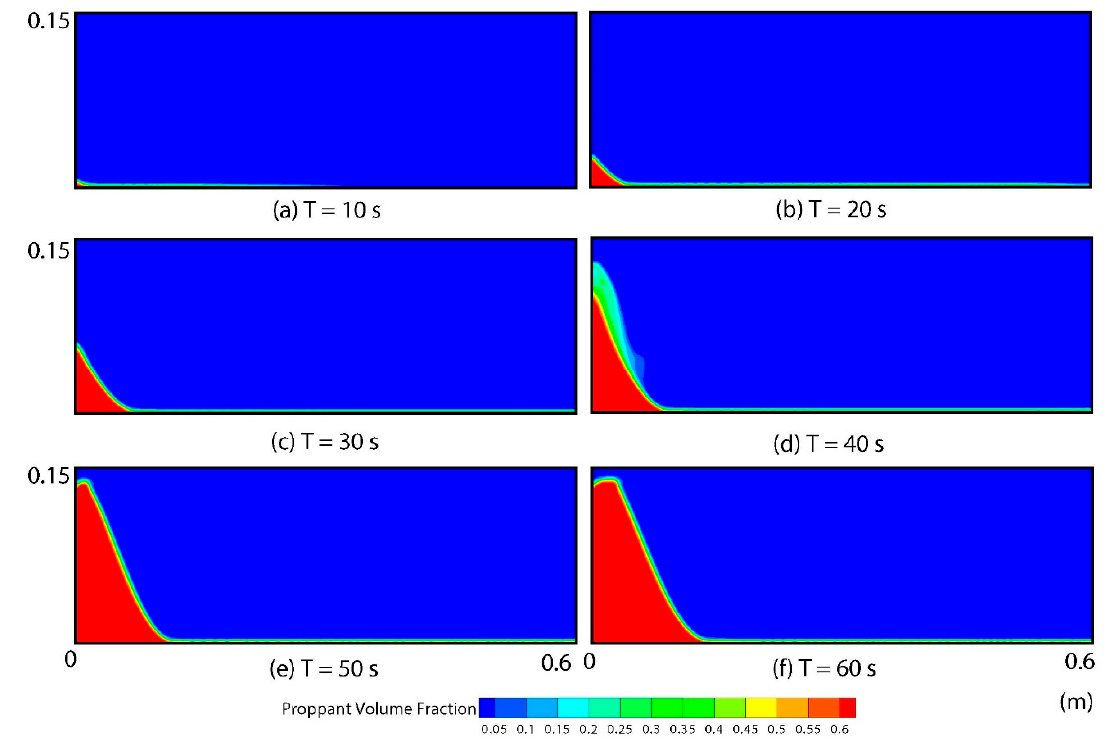
Figure 5. The formation process of the proppant bed in the secondary fracture at time ( a ) 10 s, ( b ) 20 s, ( c ) 30 s, ( d ) 40 s, ( e ) 50 s, and ( f ) 60 s. (Case 3 in Table A1).